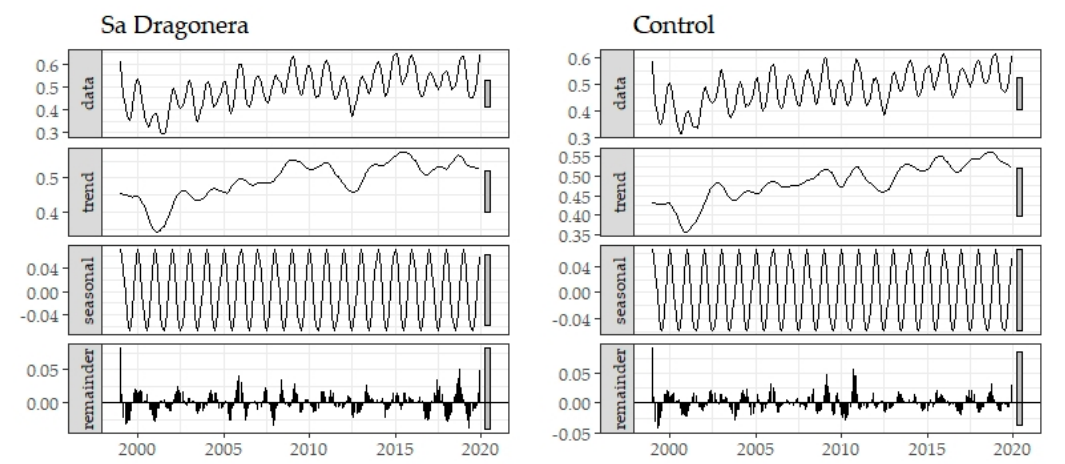
Figure 6. The STL decomposition of the monthly NDVI time series of Sa Dragonera and control zone (Mallorca Island) into seasonal, trend, and remainder components. In each plot NDVI units are plotted against time. The seasonal component is estimated by taking the mean of all seasonal sub-series (e.g., for a monthly time series the first sub-series contains the January values). The sum of the seasonal, trend, and remainder components equals the data series. The solid bars on the right-hand side of the plots act as reference to show the same data range and aid comparison.